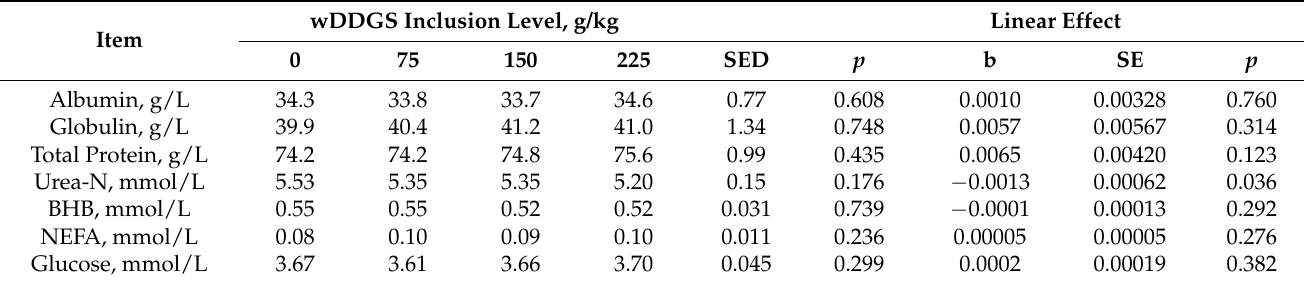
Table 6. (Experiment 2) Mean plasma metabolites of cows when fed on diets containing 0 to 225 g wDDGS DM/kg diet DM.